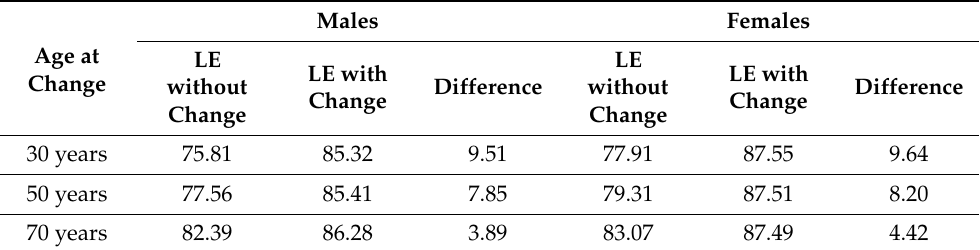
Table 7. An example of conditional LE and LE gains for males and females resulting from changing the level of exposure to 10 risk factors simultaneously, at different ages, adjusted for mediation. Males Females Age at LE LE LE with LE with Change without Difference without Difference Change Change Change Change 30 years